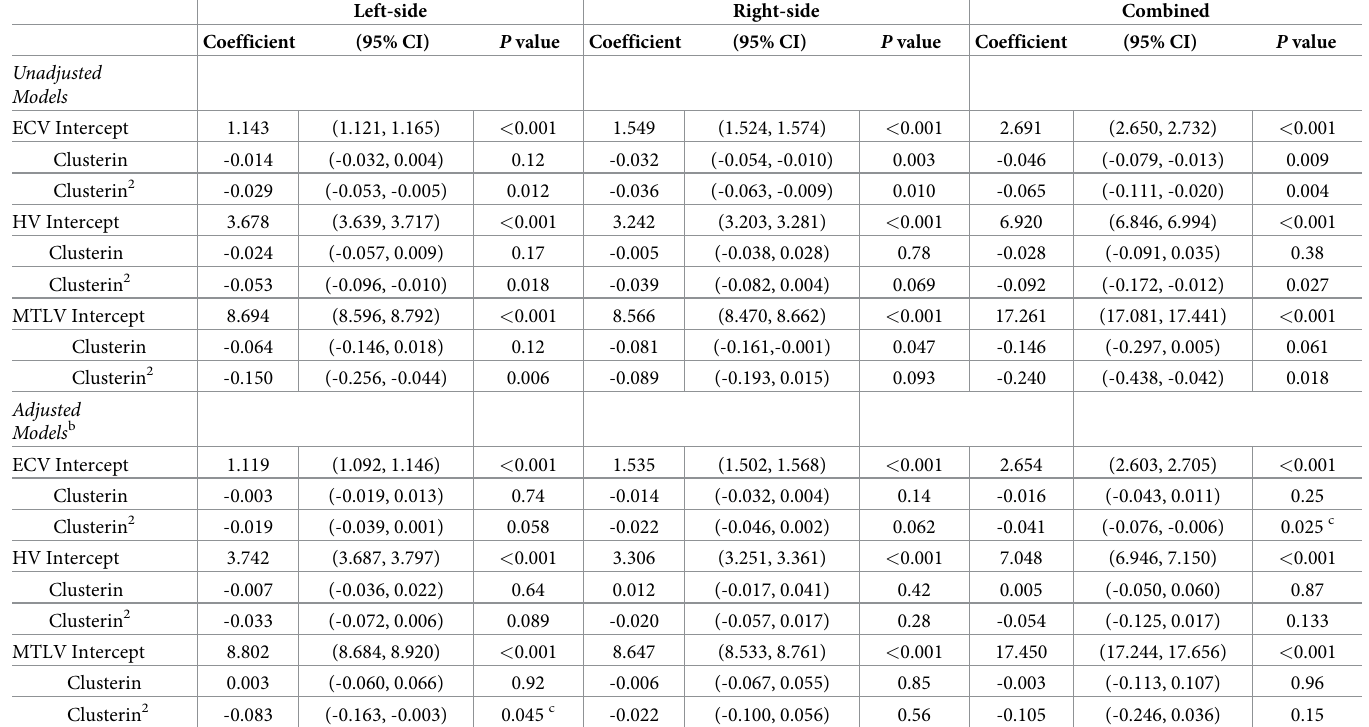
Table 3. Associations of plasma clusterin and MRI volumes for smaller brain structures a